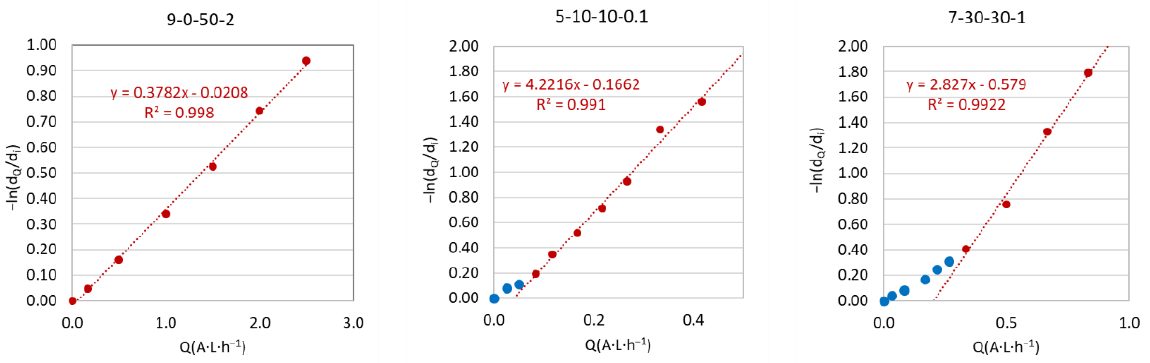
Figure 2. Examples of decolouration kinetics for the dye.